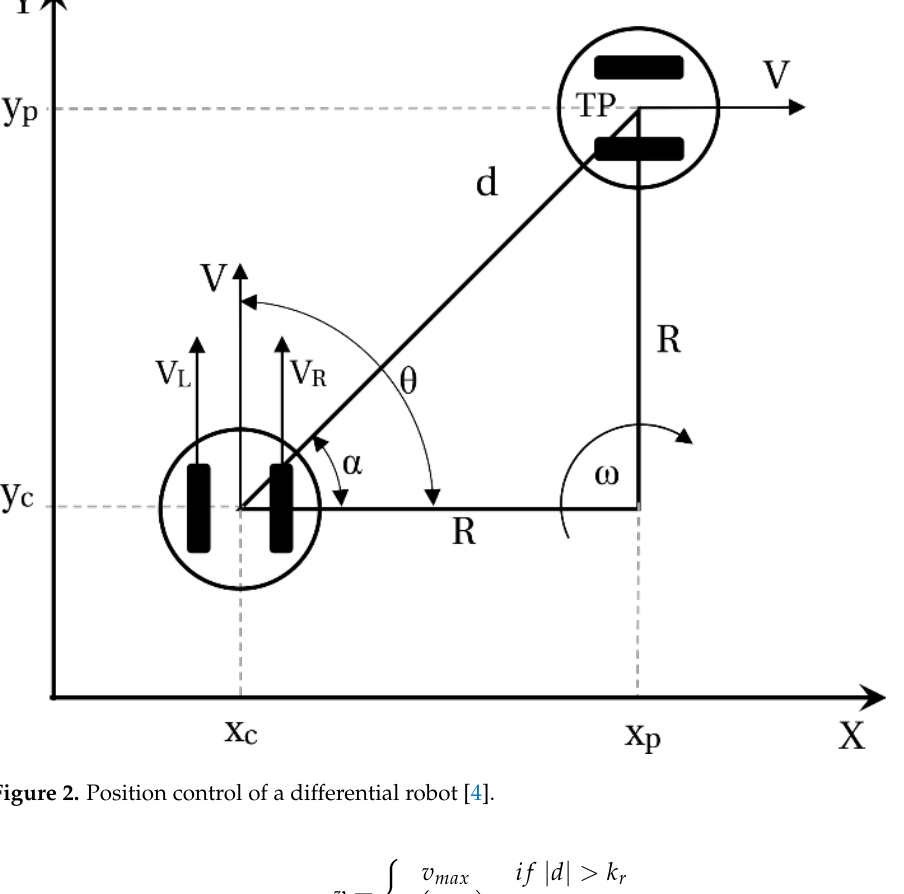
Figure 2. Position control of a differential robot [4].